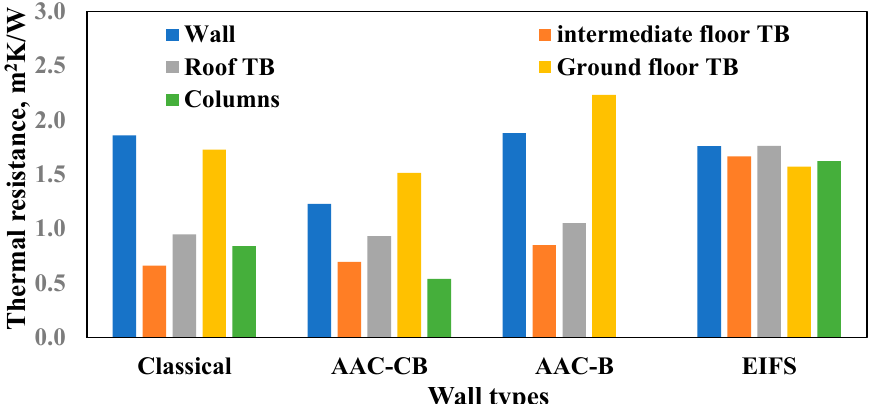
Figure 9. Thermal resistances of the various wall types and thermal bridges using the tested four walls. Table 6. Rate of heat flow per one degree, Q/ ∆ T (W/K), of the small and large buildings for various floors and the building